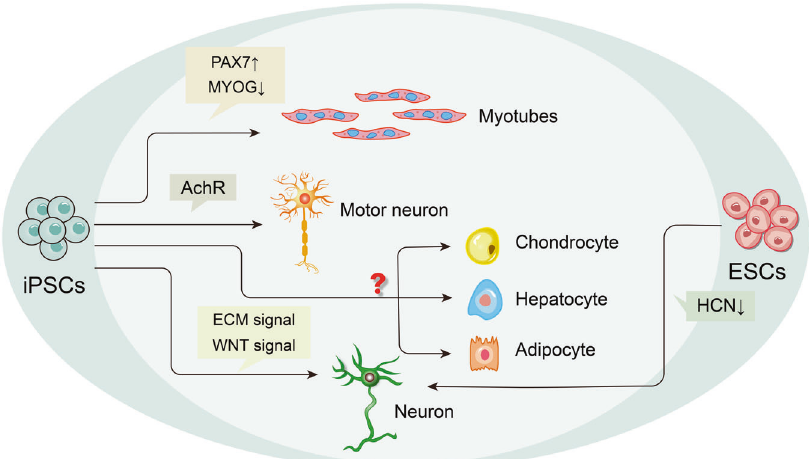
Fig. 9 Schematic diagram depicting the effect of the SHANK family on the differentiation of iPSCs/ESCs. Left: The in fl uence of SHANK on iPSC differentiation. Right: The in fl uence of SHANK on neuronal maturation from